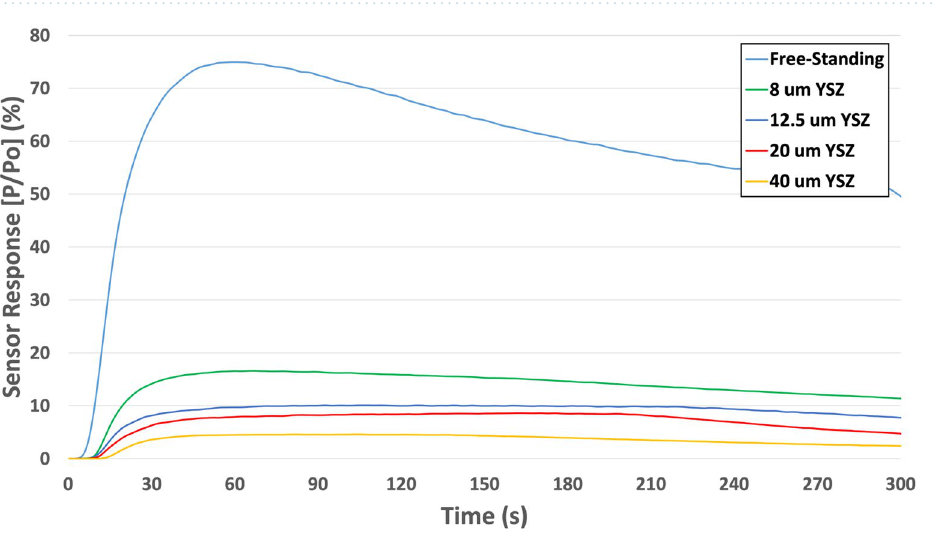
Figure 7. Responses of four different microheater sensors to 20 ppm TATP fabricated on YSZ substrates of varying thickness relative to the response of a free-standing